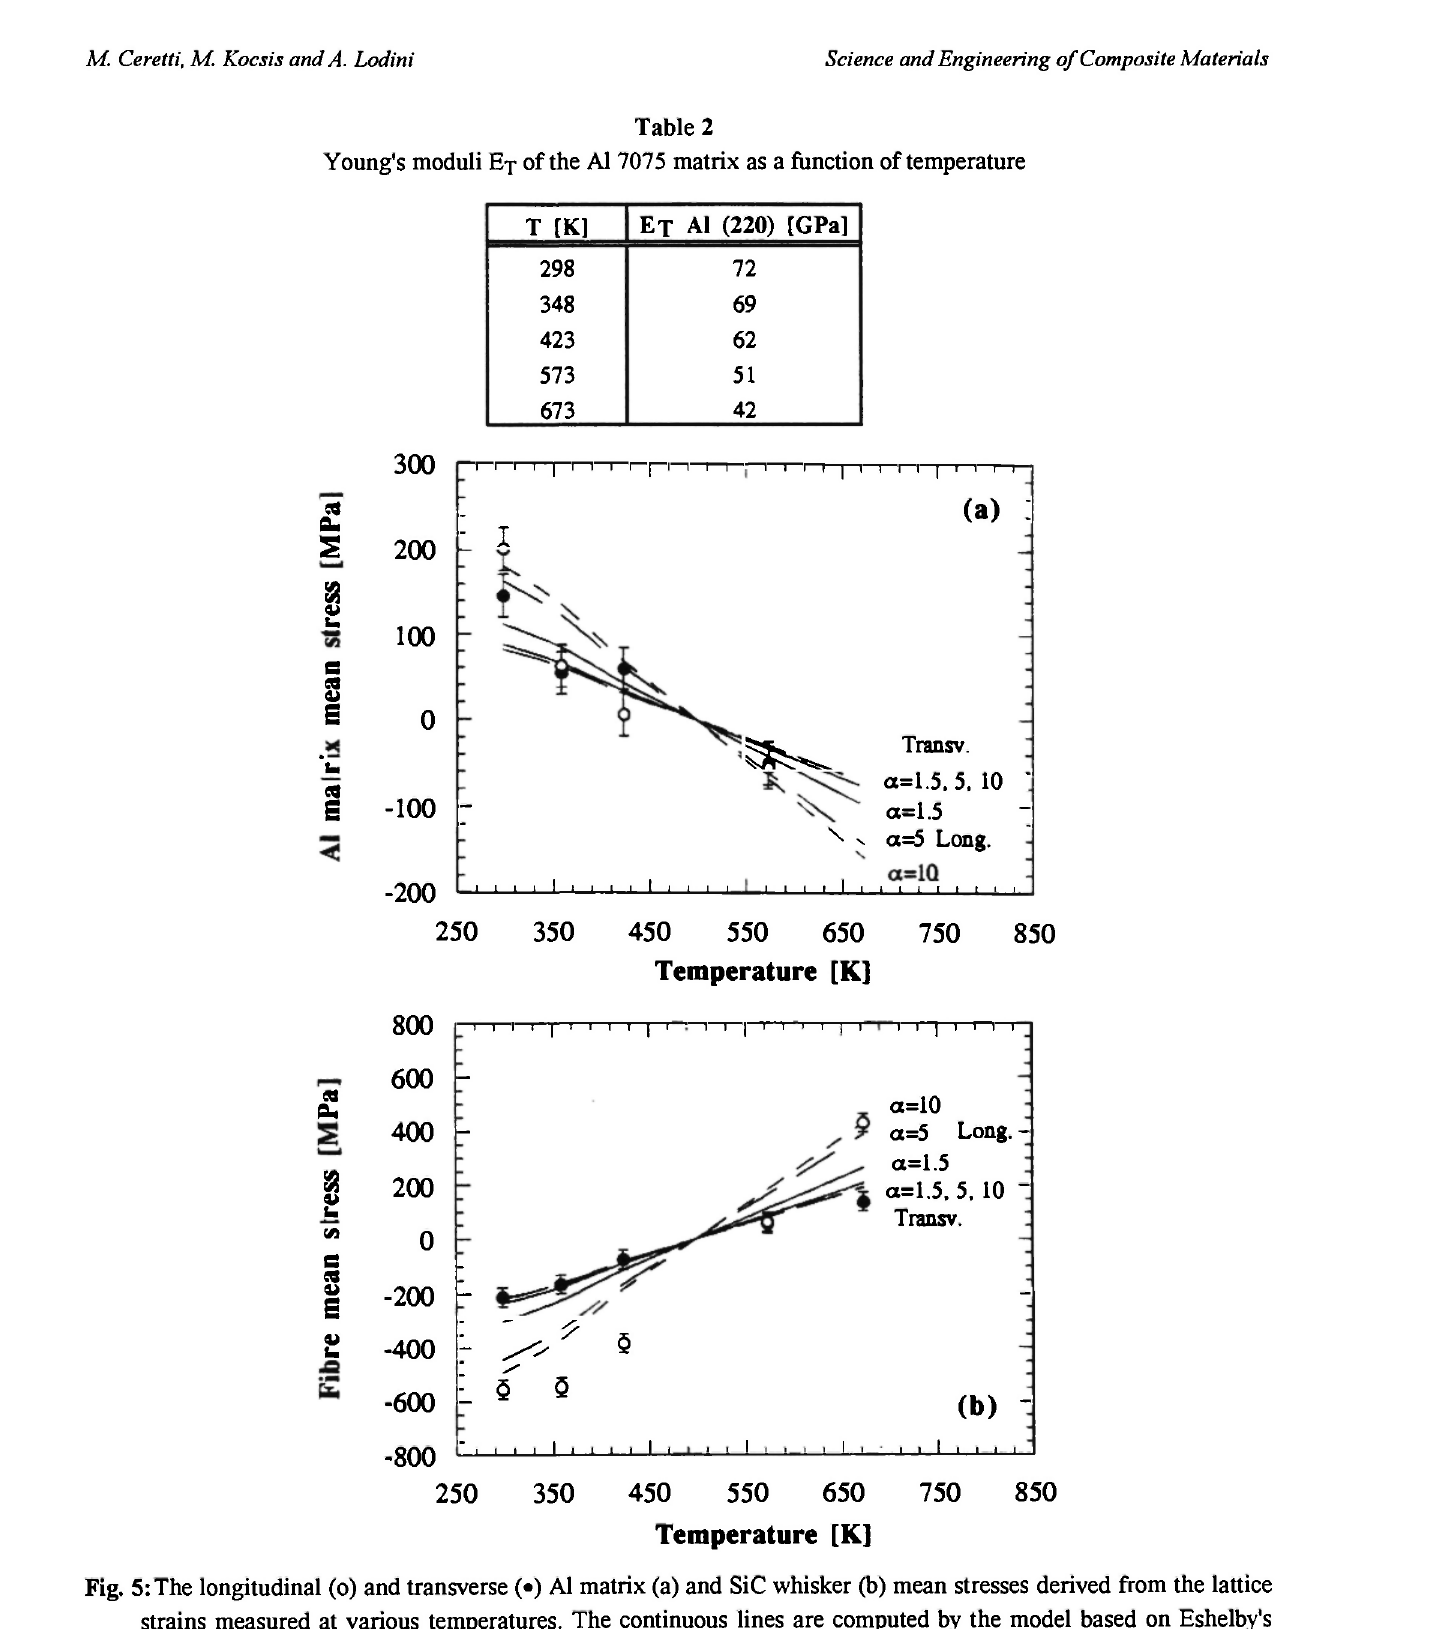
Young's moduli Εχ of the Al 7075 matrix as a function of temperature